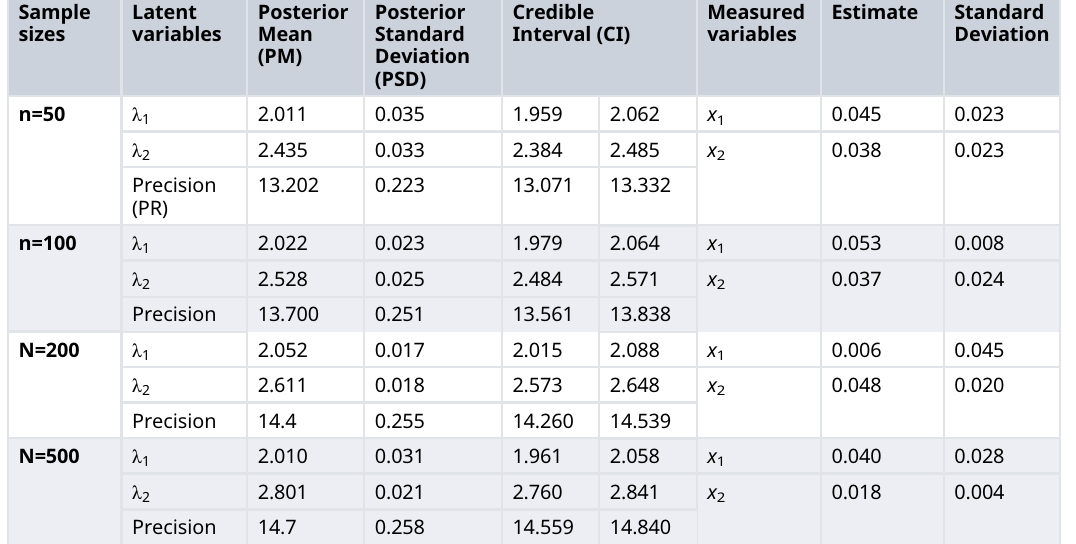
Table 1. Double logarithmic form on latent variable and observed variable